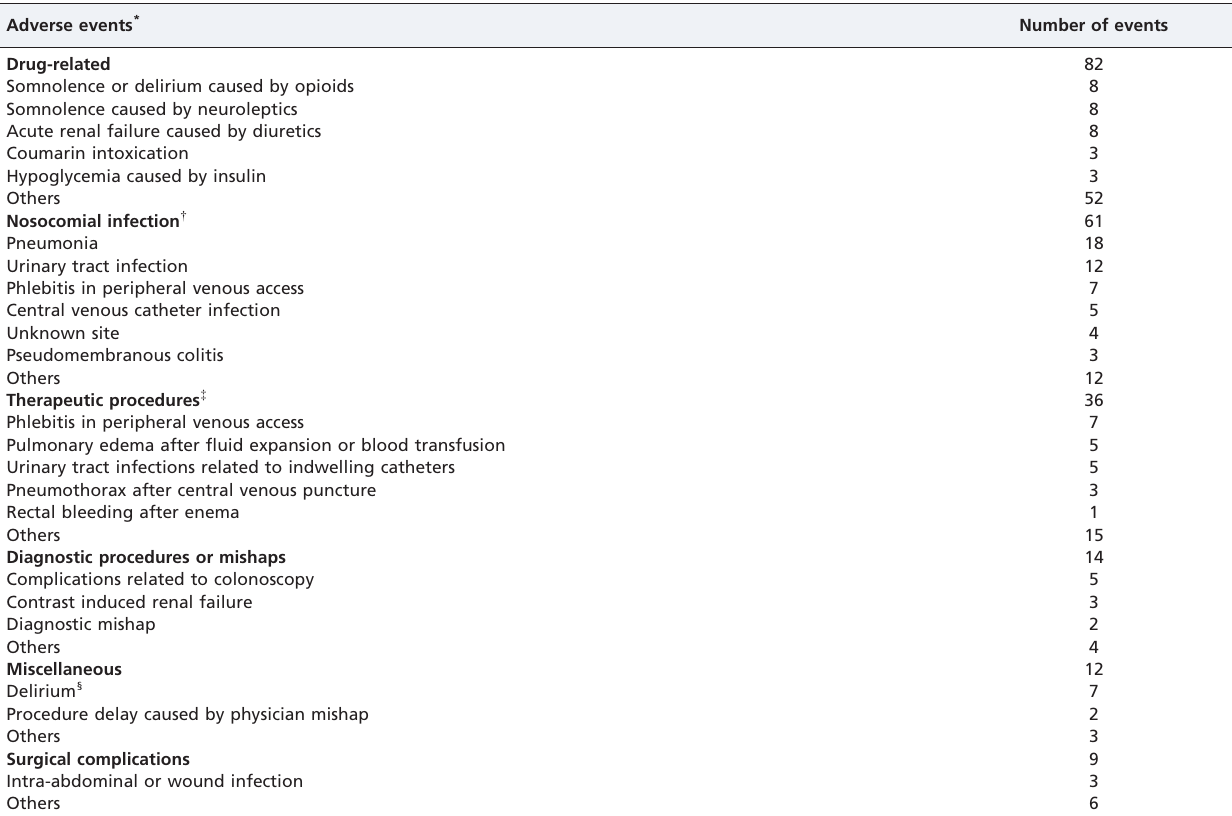
Table 2 - Frequent examples of medical adverse events.